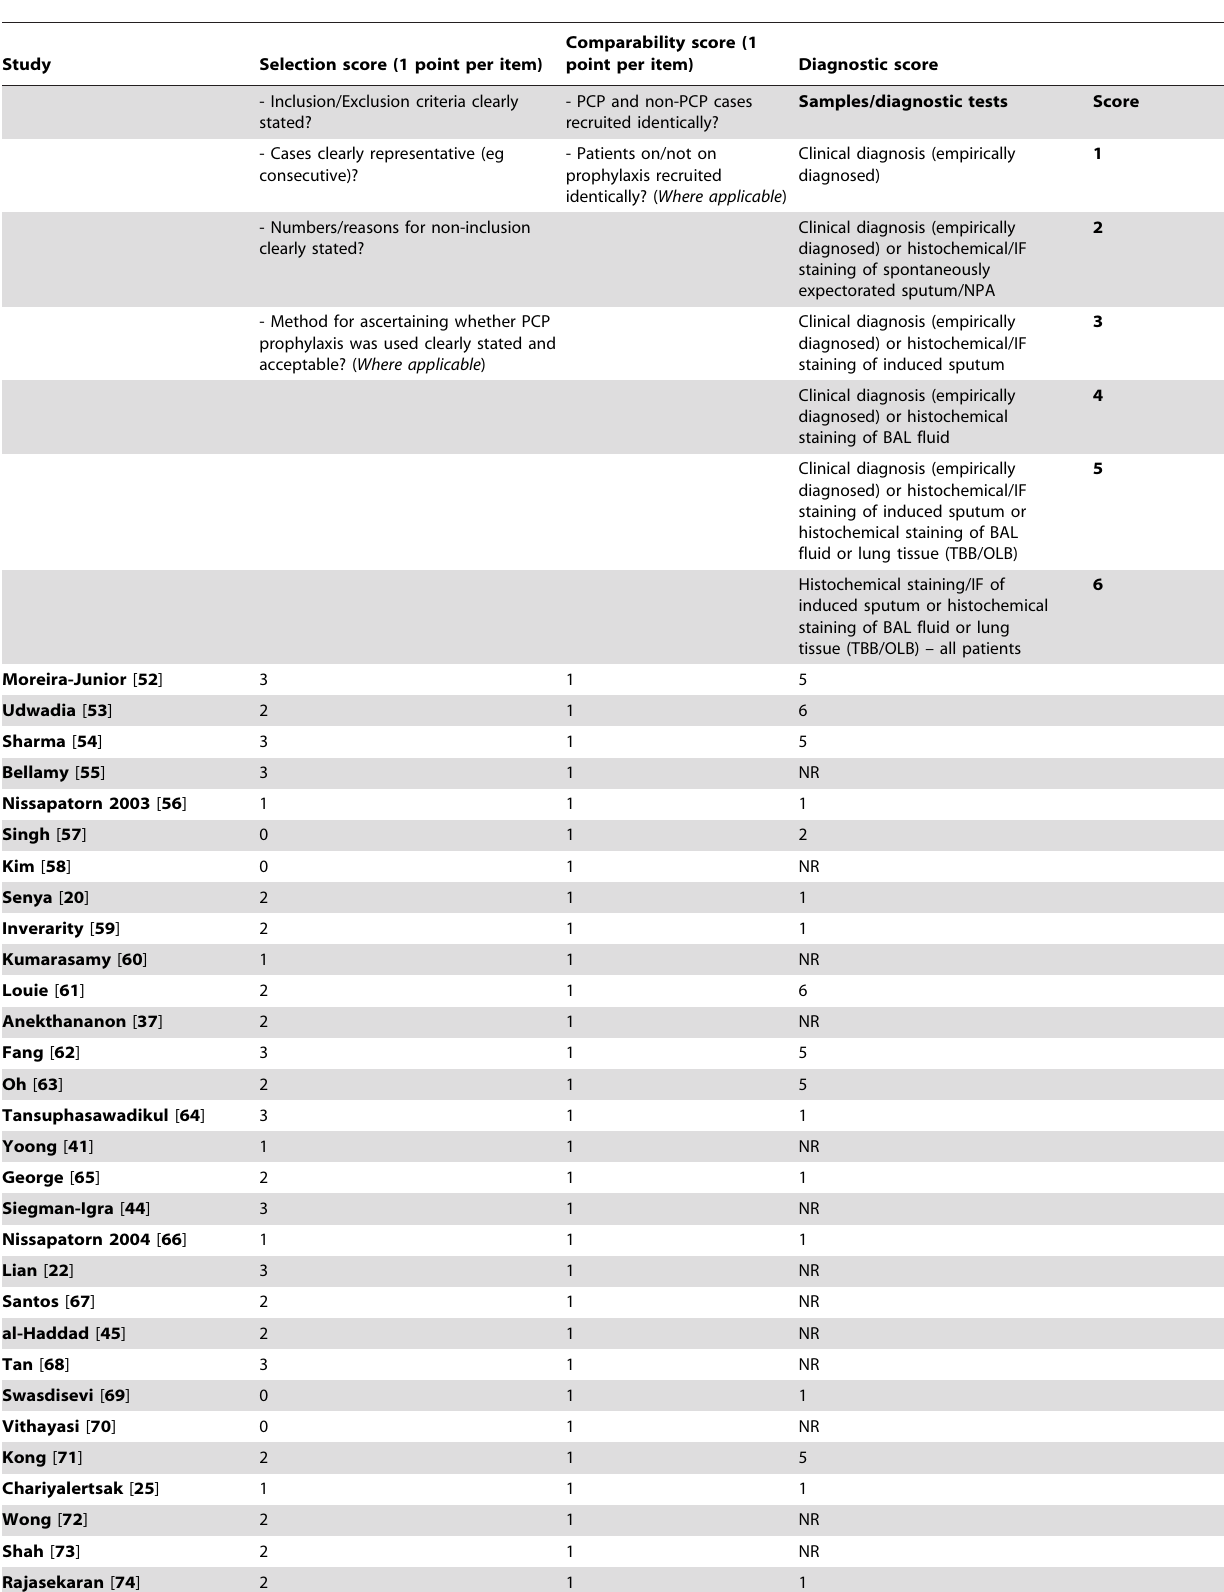
Table 2. Quality scores for studies included in primary analysis.